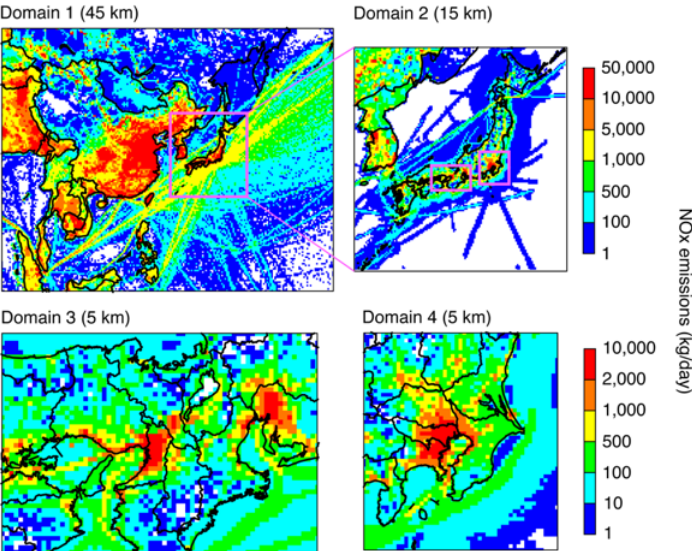
Figure 1. Mapping of NO x emissions (common dataset) over J-STREAM domains. Domain 1 (d01) covers Asia, domain 2 (d02) covers Japan, and rectangles indicate (left) domain 3 (d03) over the Kansai region and (right) domain 4 (d04) over the Kanto region. The horizontal grid resolution is 45 km for d01, 15 km for d02, and 5 km for d03 and d04.